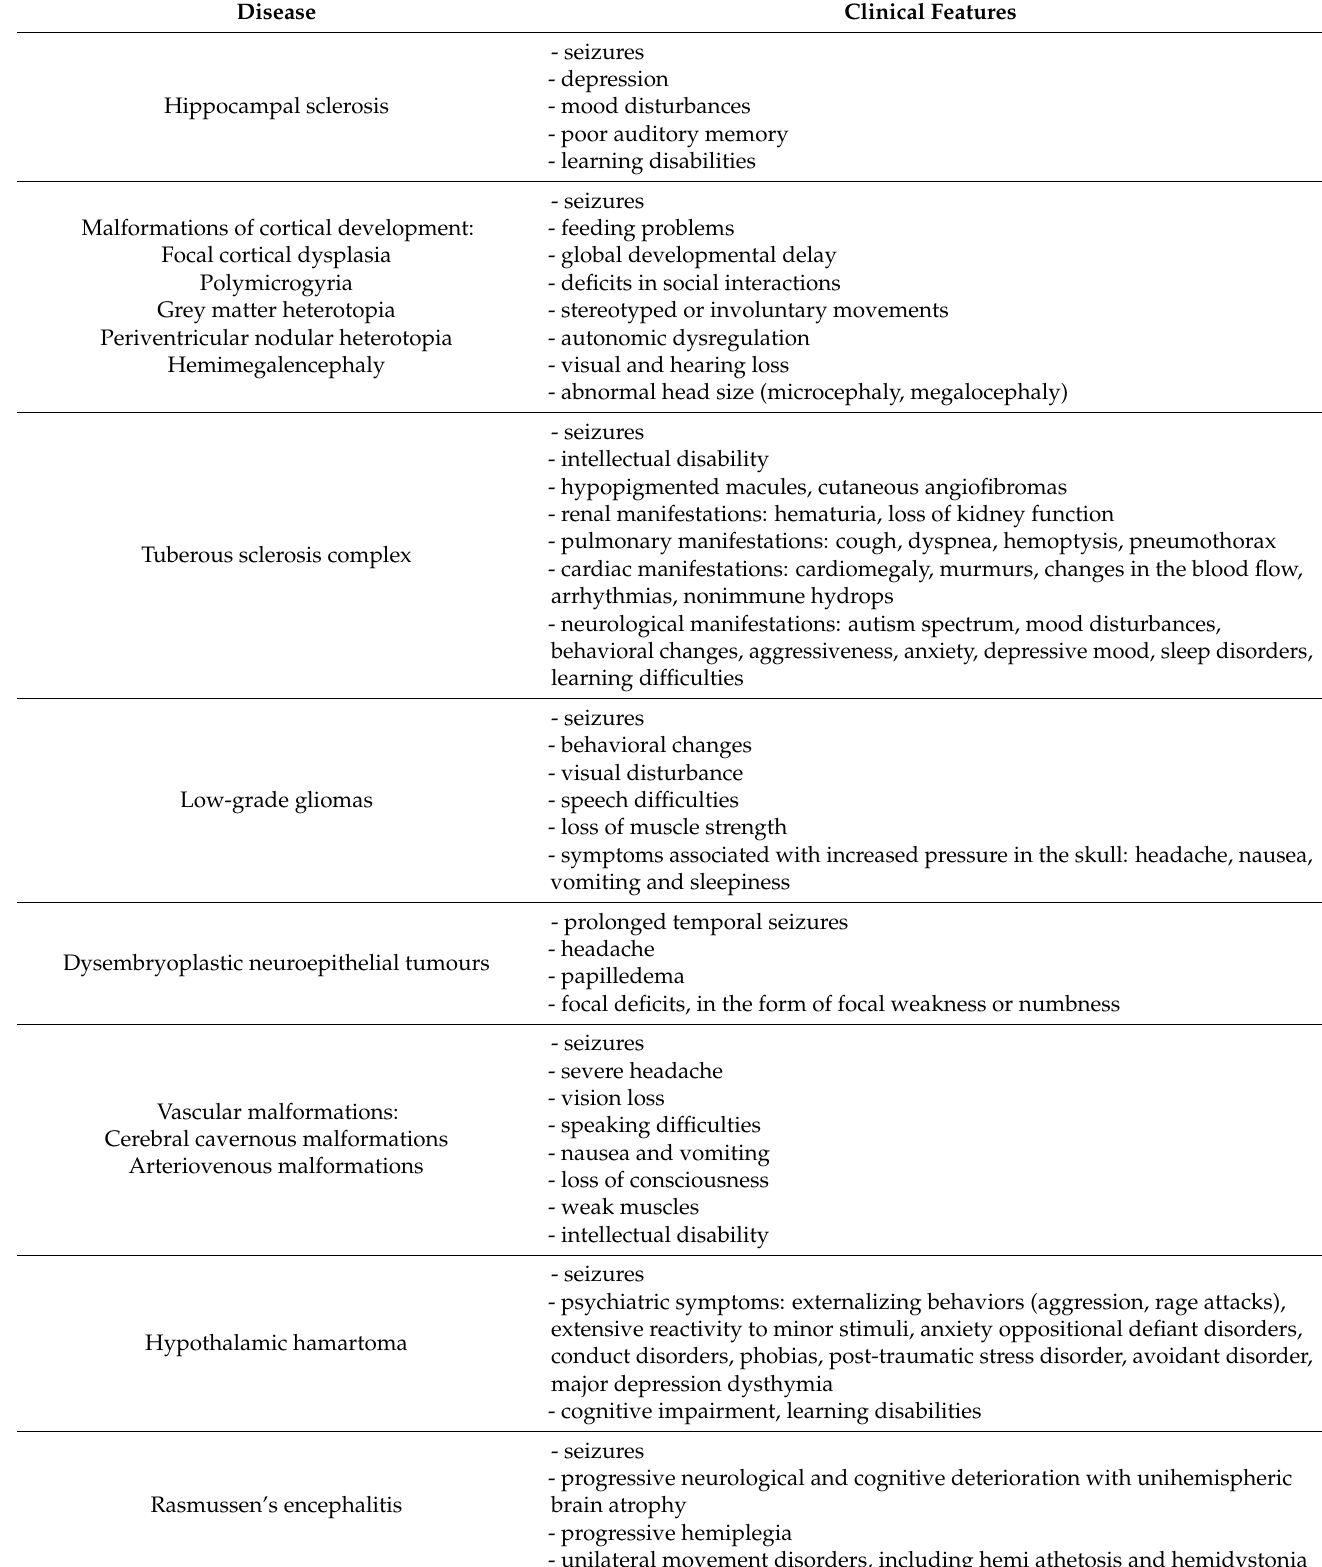
Table 2 presents the most common clinical features of epilepsy-related disorders. Table 2. Clinical features of epilepsy-related disorders